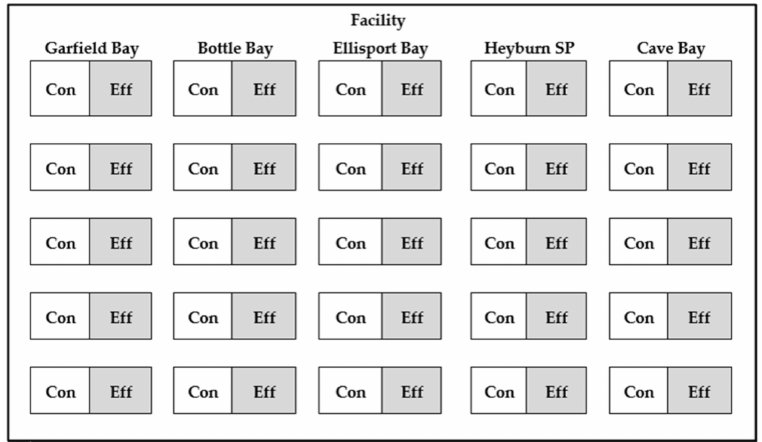
Figure A1. Schematic representation of the experimental design showing number of control (Con) and effluent (Eff) plots at each facility.